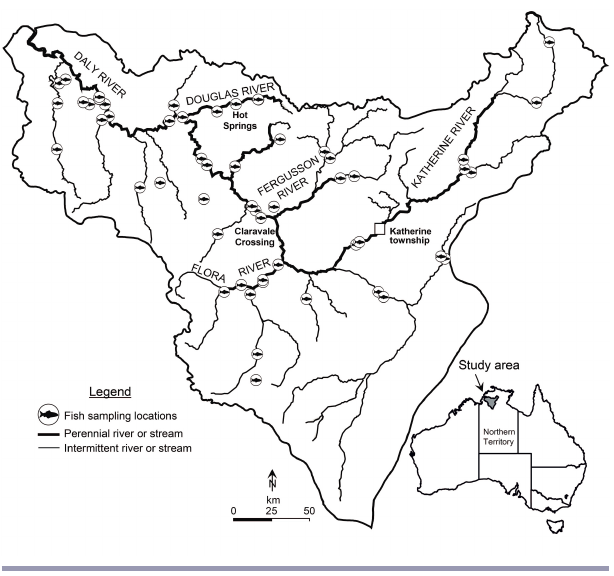
Fig. 1 . The Daly River catchment, northern Australia, showing the fish sampling sites and locations mentioned in the